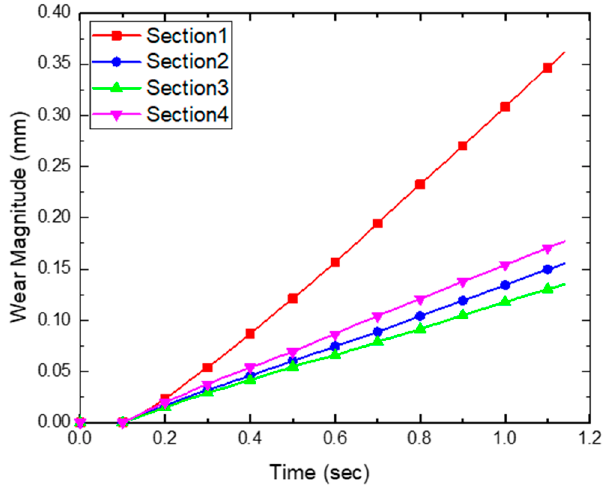
Figure 16. History of wear magnitude (average) in each section.